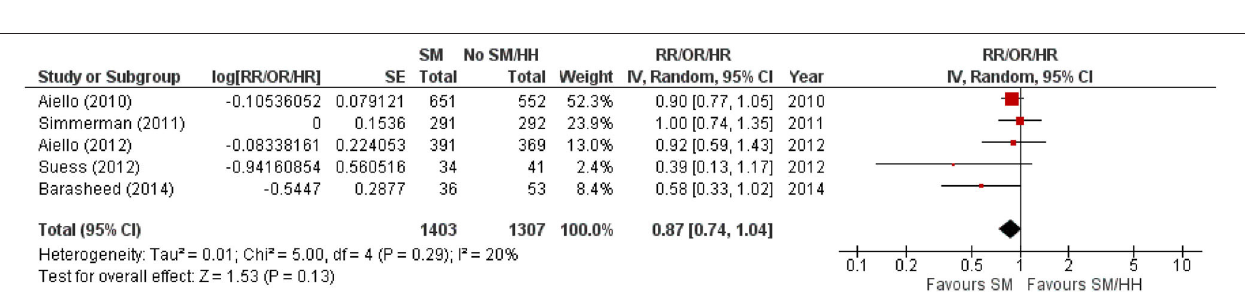
FIGURE 5 | Pooled summary statistic for ARI incidence when surgical masks were worn compared with not wearing surgical masks in cluster randomized controlled trials, estimated with the generic inverse variance method and a random-effects model. SM, surgical face mask; No SM/HH, no surgical face mask or hand-hygiene practices; RR, risk ratio; OR, odds ratio; HR, hazard